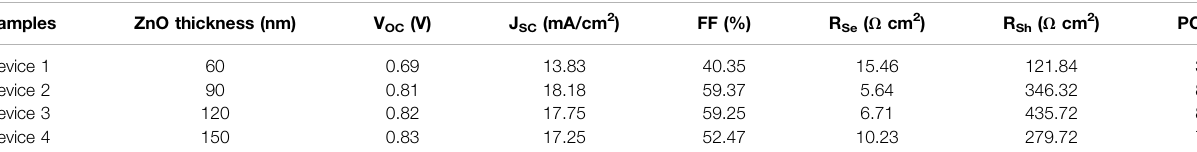
TABLE 2 | Performance of spray-coated typical devices based on AgNWs/ZnO fi lms with different ZnO thicknesses. Samples